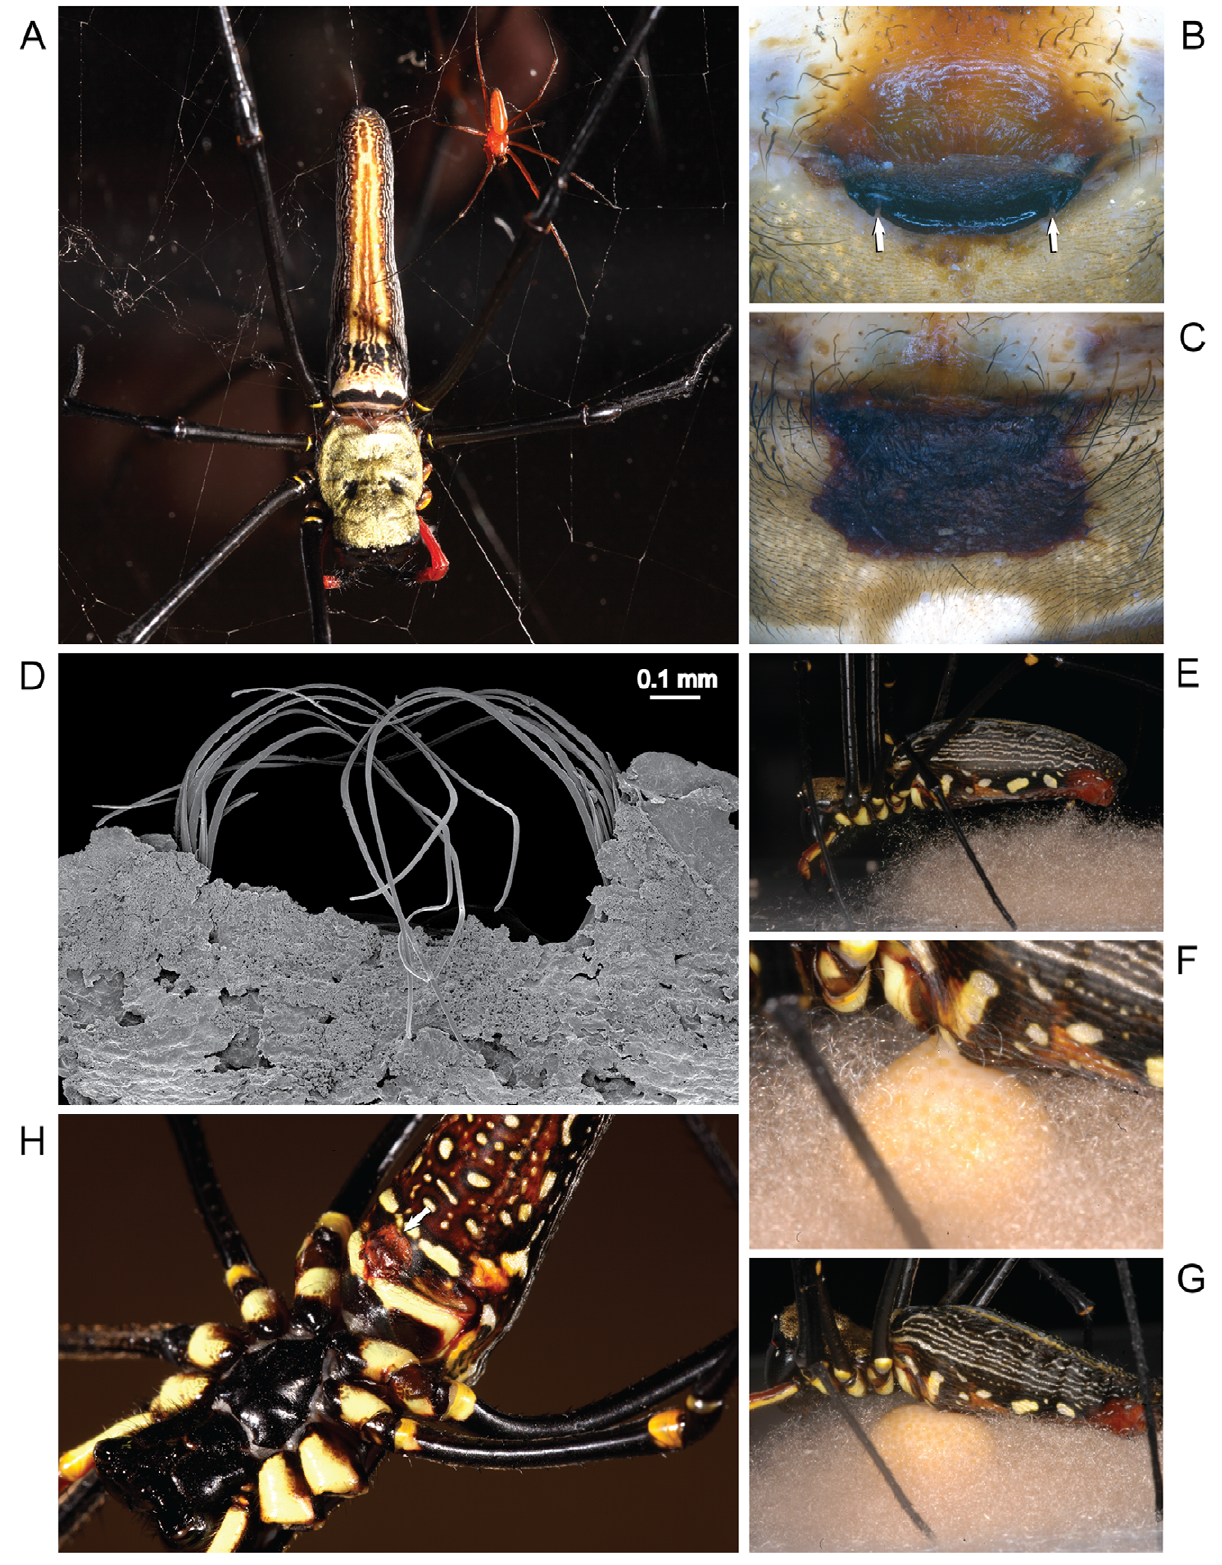
Figure 1. The amorphous plug formation in the giant wood spider Nephilapilipes , a highly polygamous and sexually dimorphic species, takes place not during mating, but during oviposition. A, giant female (left) and small male (right); B, female genital area, intact, arrows indicate paired copulatory openings; C, female genital area covered with a hard amorphous plug (AP); D, two types of plugs in a female, image shows a removed AP with several male embolic leftovers lodged in each copulatory opening; E–G, female spins an egg sac (E) and deposits in